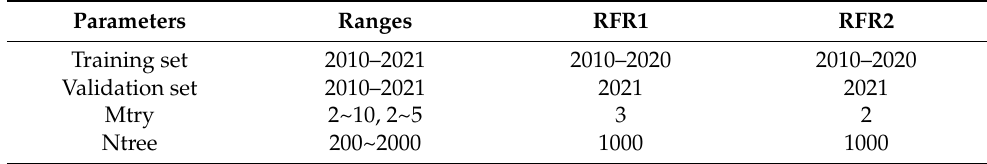
Table 5. Random forest regression parameter selection.